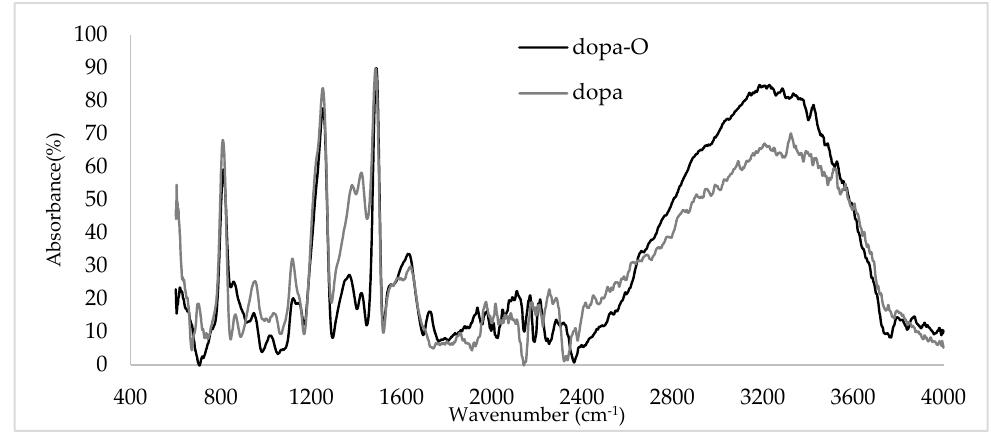
Figure 3. The Fourier transform infrared spectroscopy (FTIR) spectrum of “dopa” and “dopa-O”.